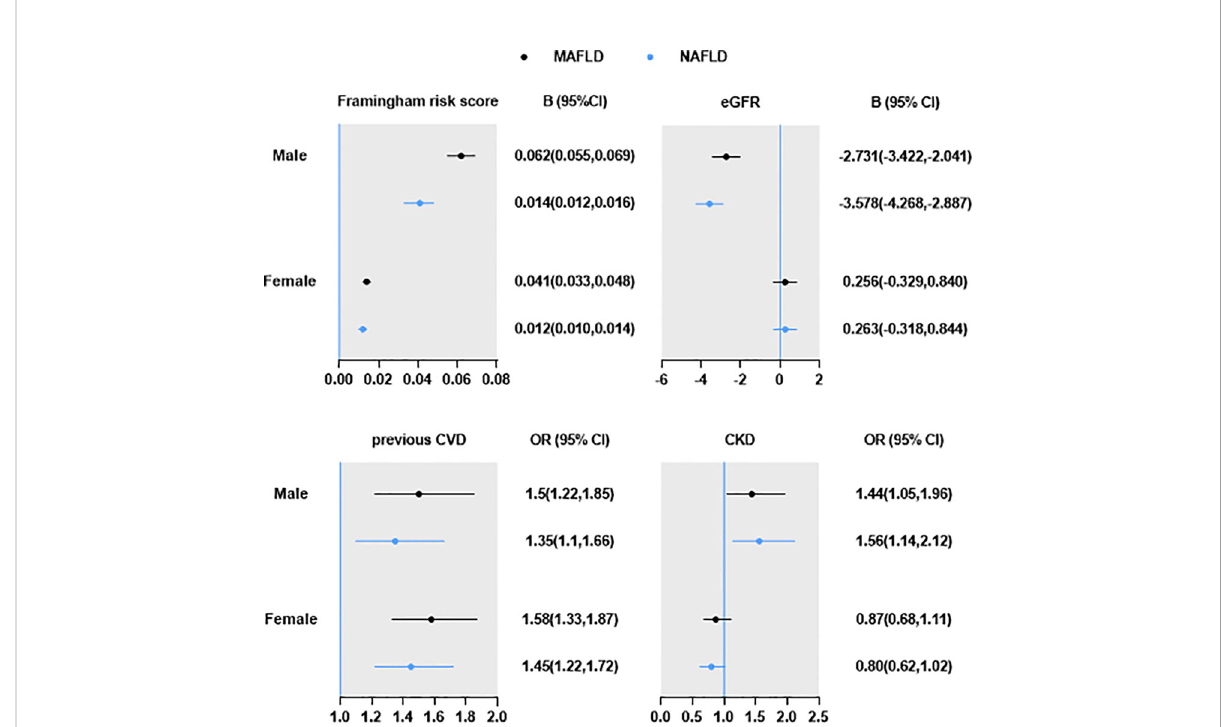
FIGURE 2 Burden of MAFLD and NAFLD on CVD and CKD. Data are expressed as OR/B (95% CI). All analyses were adjusted for age and current